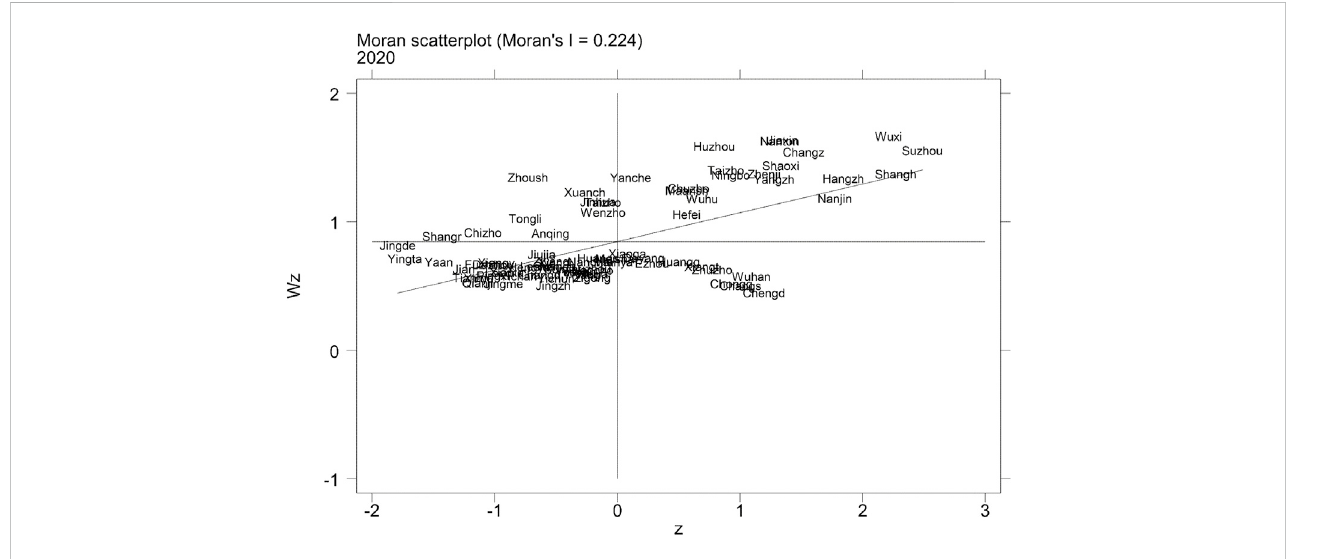
FIGURE 10 Local Moran index scatter plot in 2020.